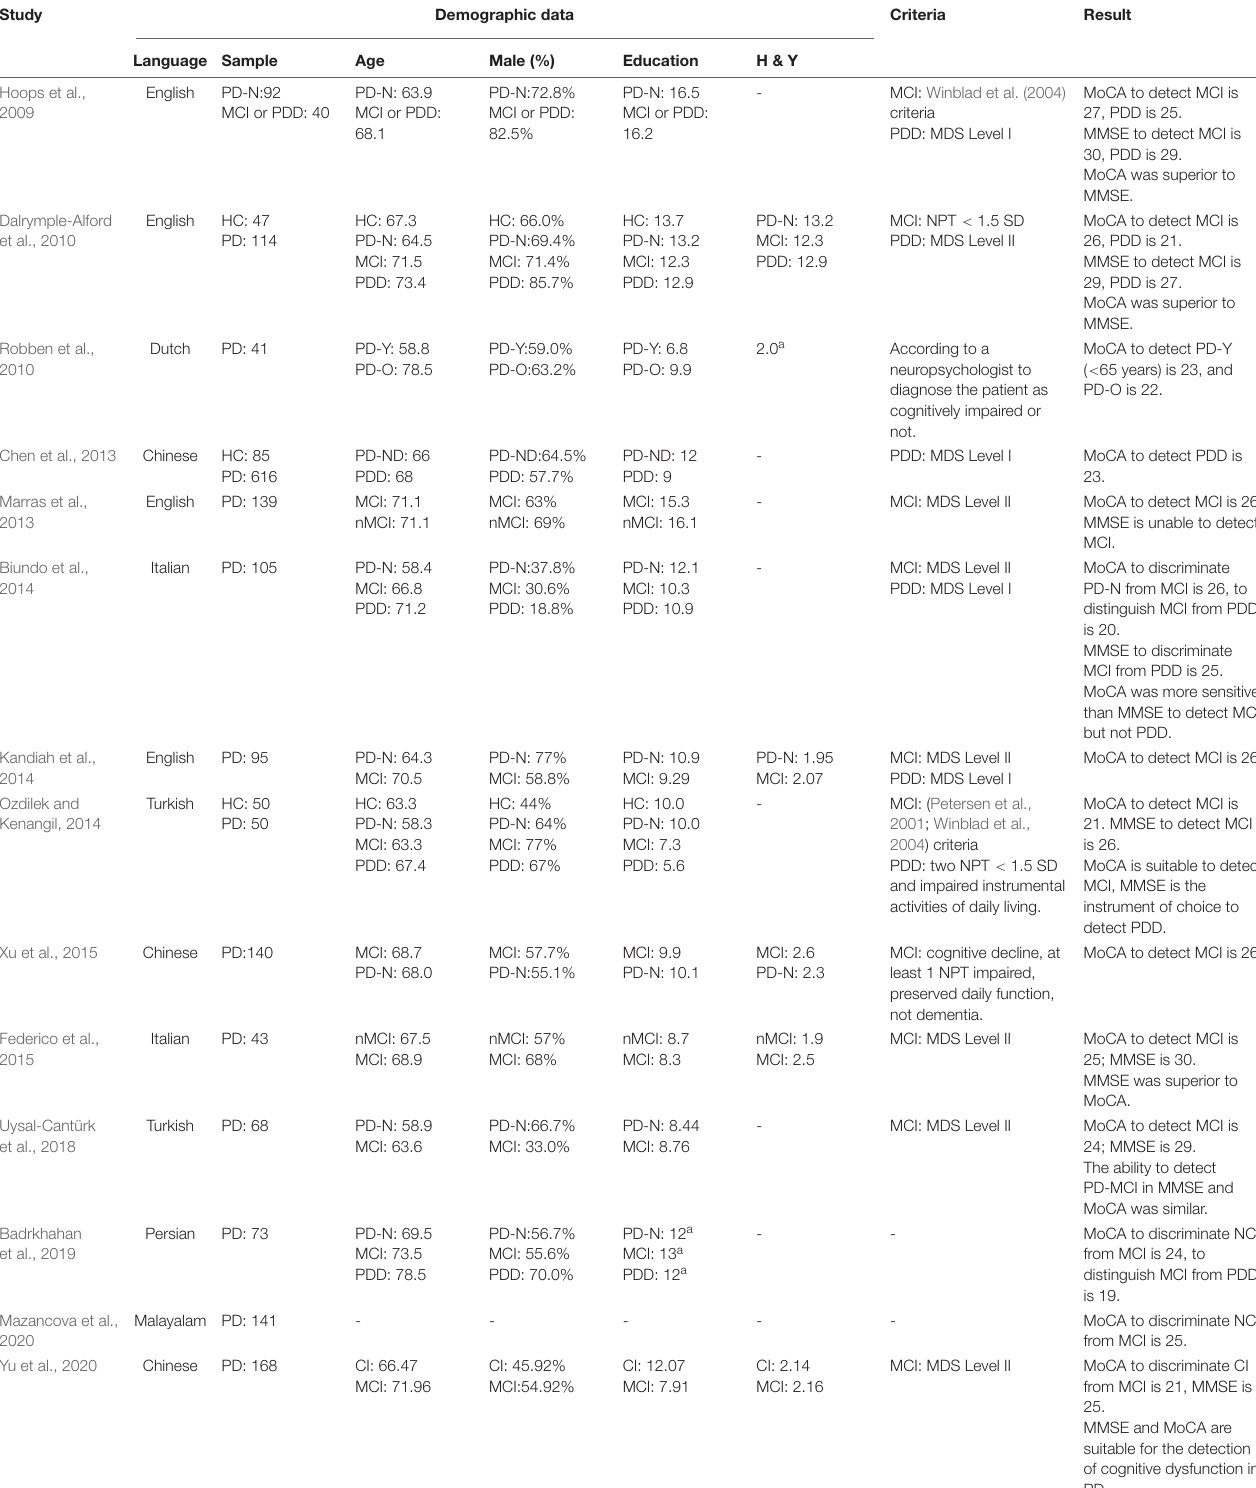
TABLE 1 | Studies assessing cognitive function by MMSE and MoCA in patients with Parkinson’s